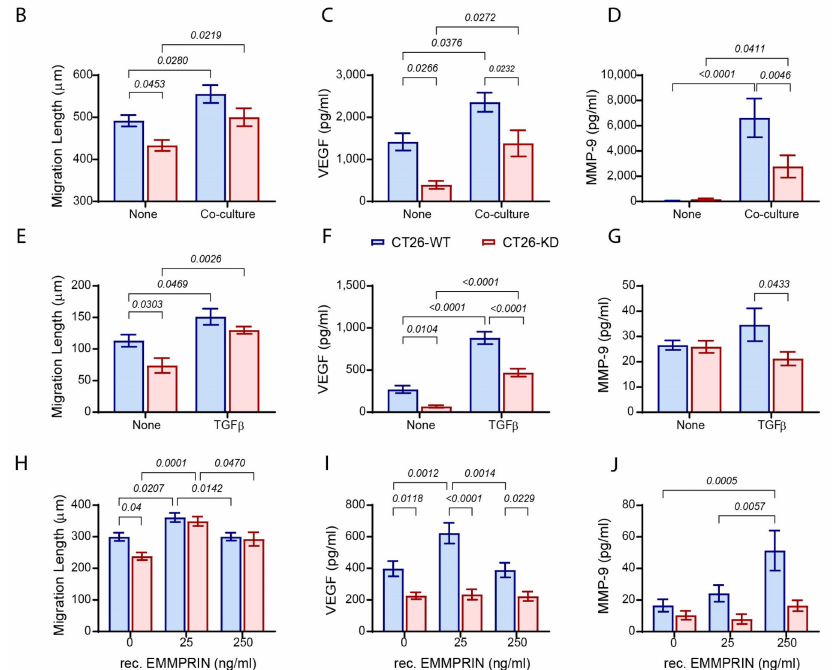
Figure 6. CT26-KD exhibits reduced angiogenic potential, and the co-culture reverses it. The mouse endothelial cell line bEND3 (4 × 10 4 cells) was cultured in full medium in 96-well plates to confluency for 24 h. A scratch was made across the monolayer, detached cells were washed away, and the remaining bEND3 cells were incubated with conditioned media (CM) derived from previous experiments for 24 h, in order to allow the migration of cells to close the gap. The CM was diluted 1:2 with full medium, to a final volume of 100 µ L. Images were taken before the addition of the CM (0 h) and after 24 h of incubation with the CM (24 h). ( A ) Representative images of the wound assay of co-cultures. Bar size is 250 µ M. ( B ) Quantitation of the migration of bEND3 cells cultured with CM from co-culture experiments ( n = 12), with ( C ) concentrations of VEGF ( n = 7) and ( D ) MMP-9 ( n = 7) in the supernatants derived from co-culture experiments. ( E ) Quantitation of the migration using CM derived from the TGF β experiments ( n = 5), and concentrations of ( F ) VEGF ( n = 8) and ( G ) MMP-9 ( n = 5) in the supernatants derived from TGF β experiments. ( H ) Quantitation of the migration using CM derived from the recombinant EMMPRIN experiments ( n = 9), and concentrations of ( I ) VEGF ( n = 9) and ( J ) MMP-9 ( n = 7) in the supernatants derived from recombinant EMMPRIN experiments. Data are presented as means ± SE, and analyzed using two-way ANOVA followed by Bonferroni’s post-hoc